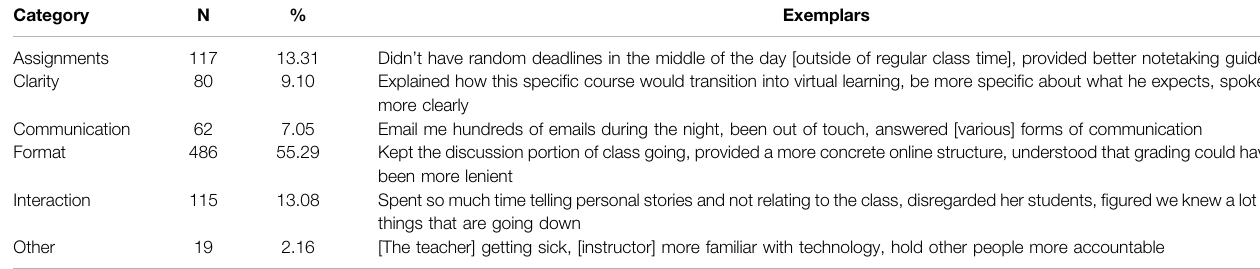
TABLE 1 | Content analysis categories.